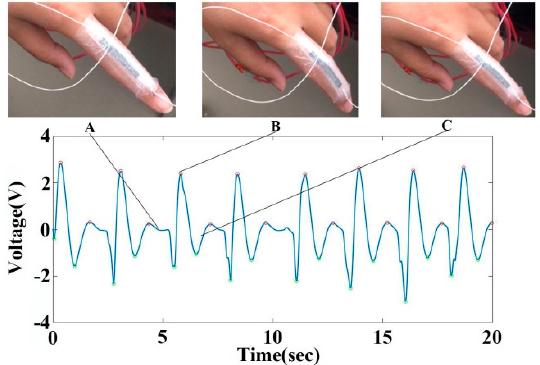
Figure 5. Signal acquired by graphene sensor for monitoring finger bending motion. A, B and C correspond to the finger resting state, finger flexion state and finger recovery state, respectively.